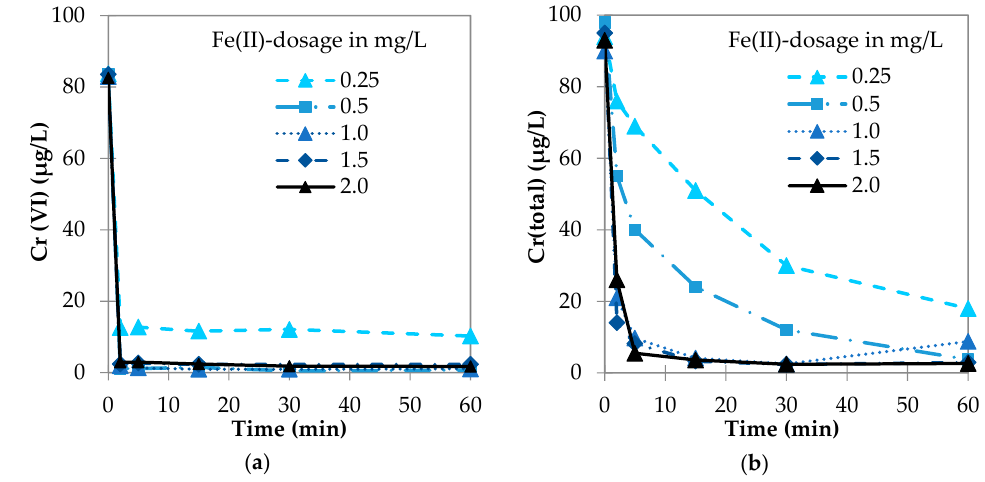
Figure 2. Removal kinetics of ( a ) Cr(VI) and ( b ) Cr(total) concentrations at pH value 7 and Fe(II) dosages 0.25, 0.5, 1, 1.5, and 2 mg/L. All experiments were performed using set-up A.